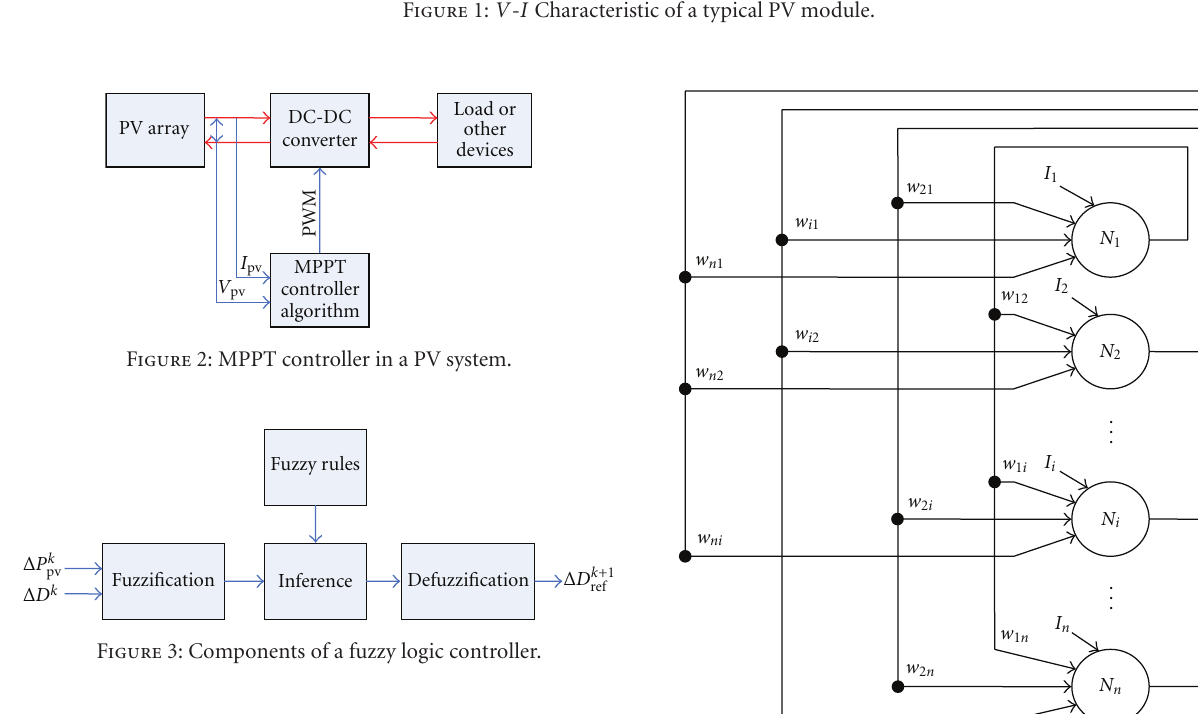
Figure 1: V - I Characteristic of a typical PV module.